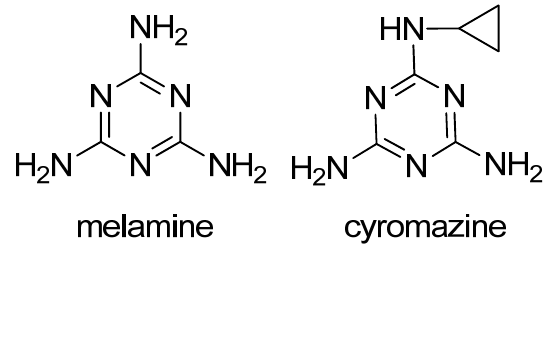
Figure 1. Structures of melamine and cyromazine.